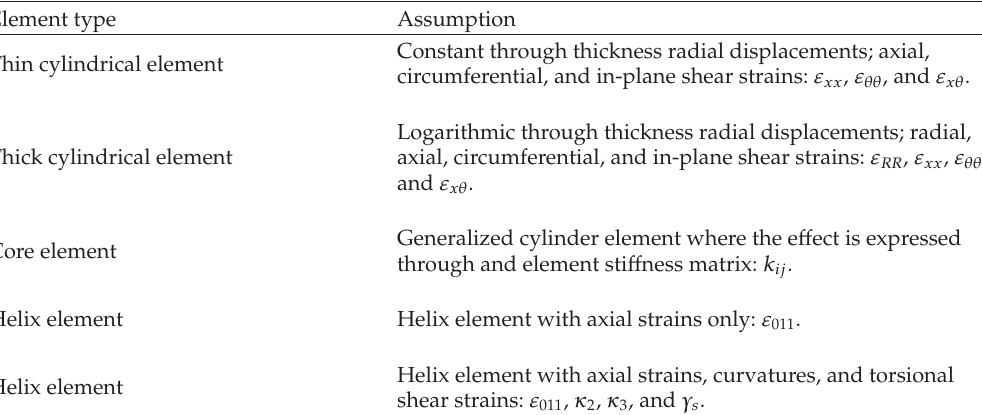
Table 1: Typical elements used in modeling and analysis of axis-symmetrical